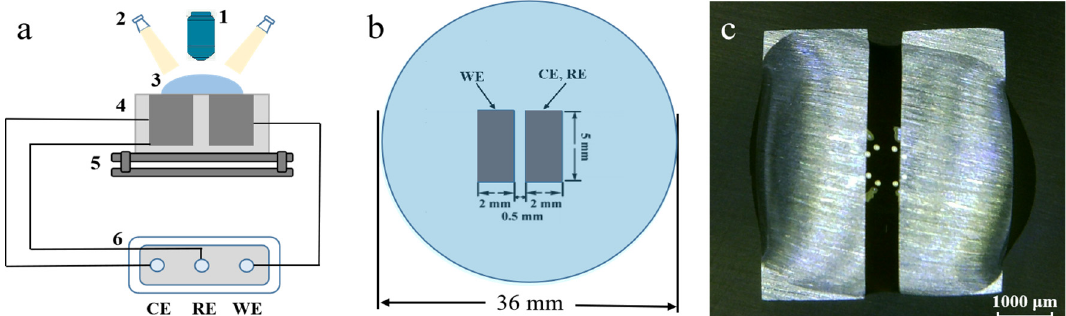
Figure 1. Schematic diagram of setup for electrochemical migration using the water drop test (WDT): ( a ) (1) digital microscope; (2) cold light sources; (3) waterdrop; (4) electrodes; (5) horizontal stage; (6) electrochemical workstation; ( b ) vertical view of electrode; ( c ) optical photo of waterdrop before electrochemical migration (ECM) test.